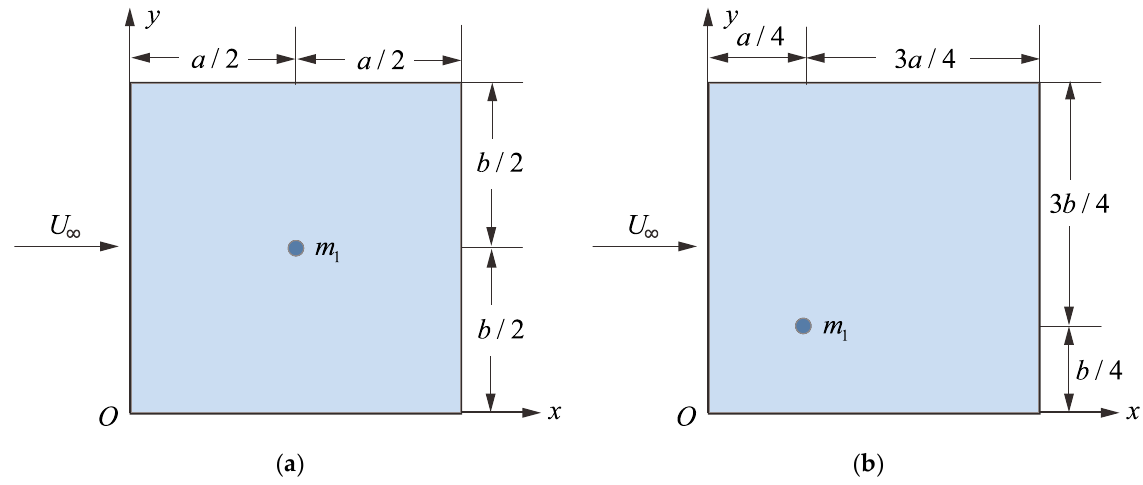
Figure 5. Two different positions of a mass attachment: ( a ) the center point of the panel (CP); ( b ) the intersection point located at 1/4 span length and 1/4 chord length (QP).